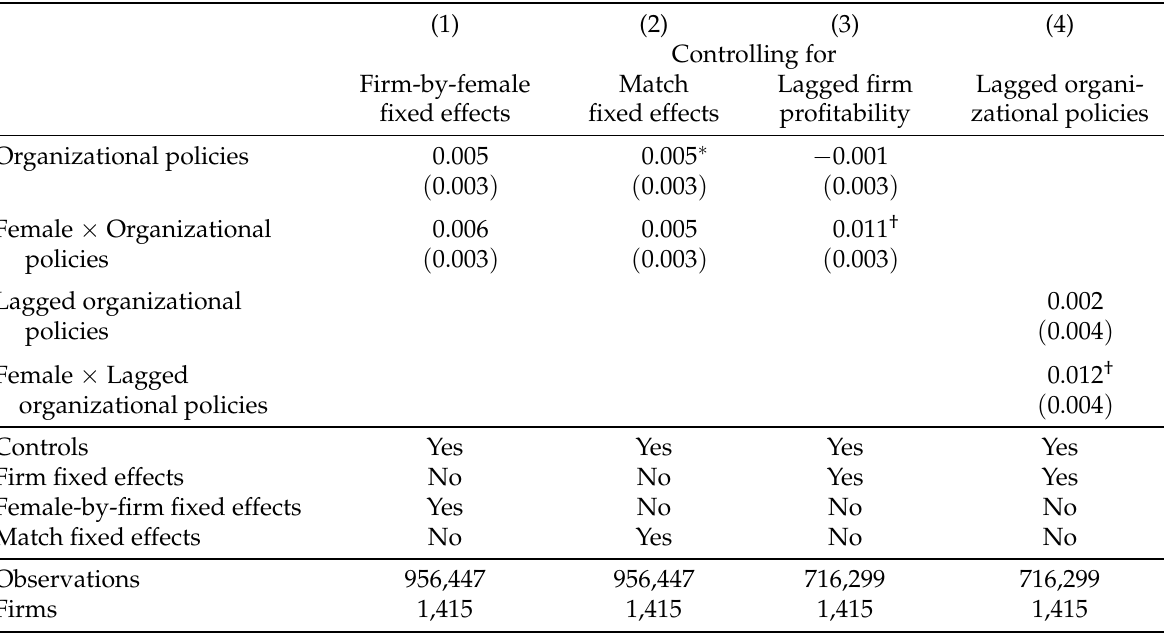
Table 6: Female friendliness, match fixed effects, and reverse